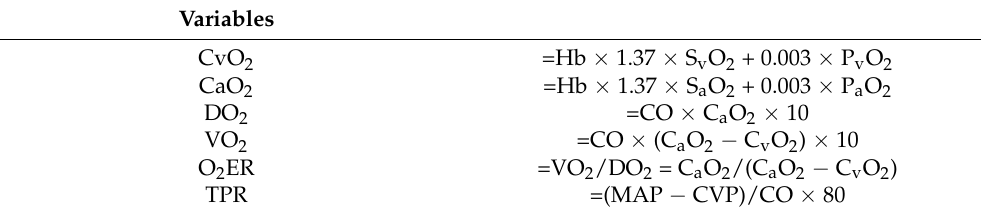
Table 1. Employed formulas for the calculation of venous and arterial oxygen content, oxygen delivery, oxygen consumption, oxygen extraction ratio and total peripheral